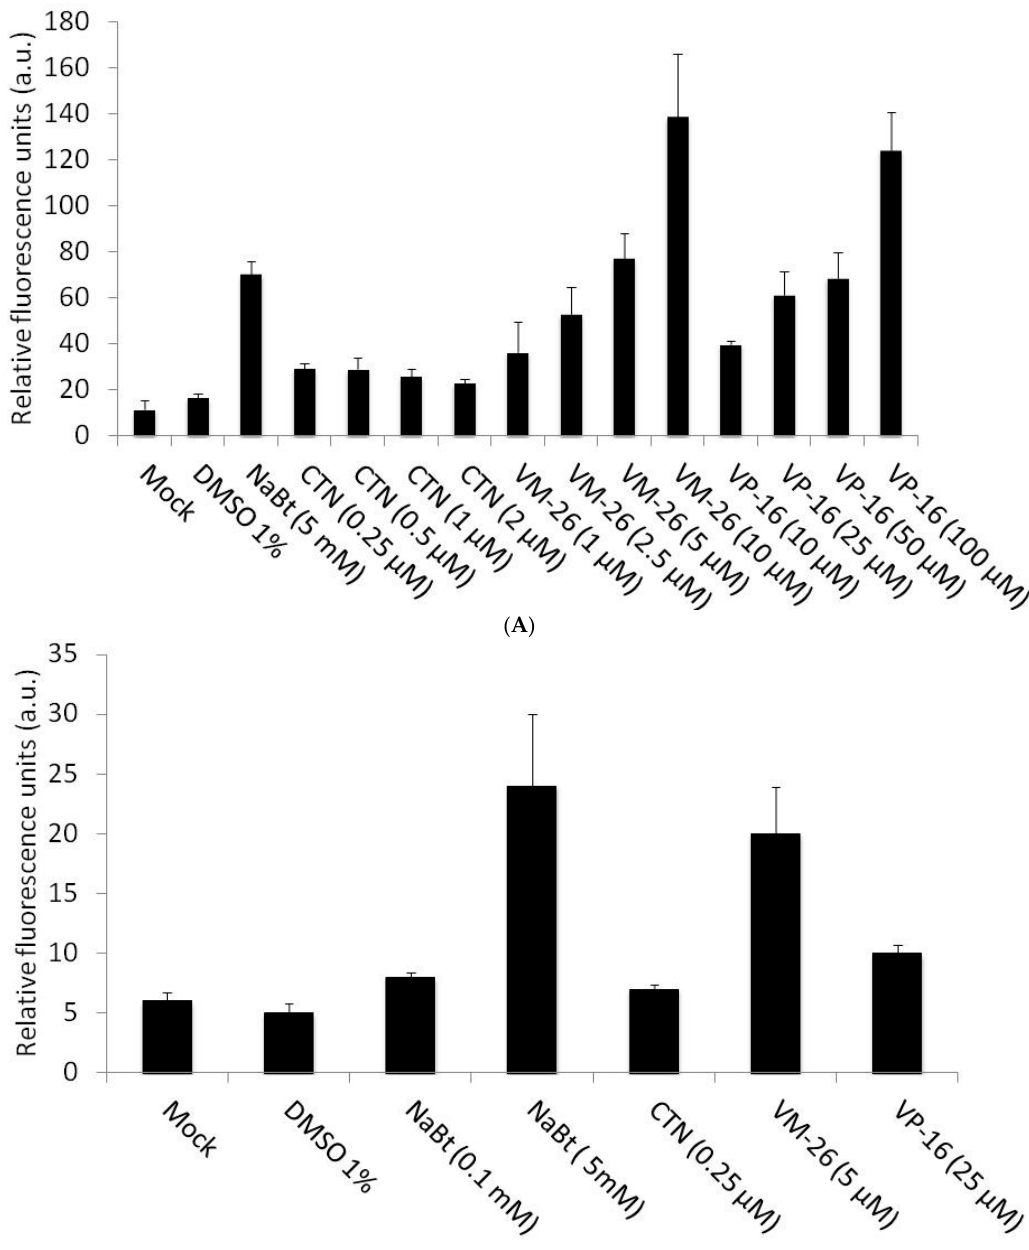
Figure 3. Top II inhibitors enhance BacMam-mediated gene expression in U-2OS cells more than a Top I inhibitor, camptothecin (CTN). ( A ) Spectrofluorometric measurement of EGFP fluorescence from U-2OS cell lysates (5 × 10 4 cells seeded in a 24-well plate) transduced with vAc-CMV- α Syn·EGFP (moi = 100) and in the presence of CTN (0.25–2 μ M), a Top I inhibitor, or Top II inhibitors, VM-26 (1–10 μ M) and VP16 (10–100 μ M) as indicated for 24 h; ( B ) Spectrofluorometric measurement of EGFP fluorescence from HepG2 cell lysates (5 × 10 4 cells seeded in a 24-well plate) transduced with vAc-CMV- α Syn·EGFP (moi = 100) after 24 h in the presence of CTN (0.25 μ M), VM-26 (5 μ M) and VP16 (25 μ M). EGFP fluorescence emission was excited at 488 nm and monitored at 507 nm. Mock treatments, 1% DMSO or NaBt were used as controls. All of the data are presented as the mean ± SD of three independent experiments.